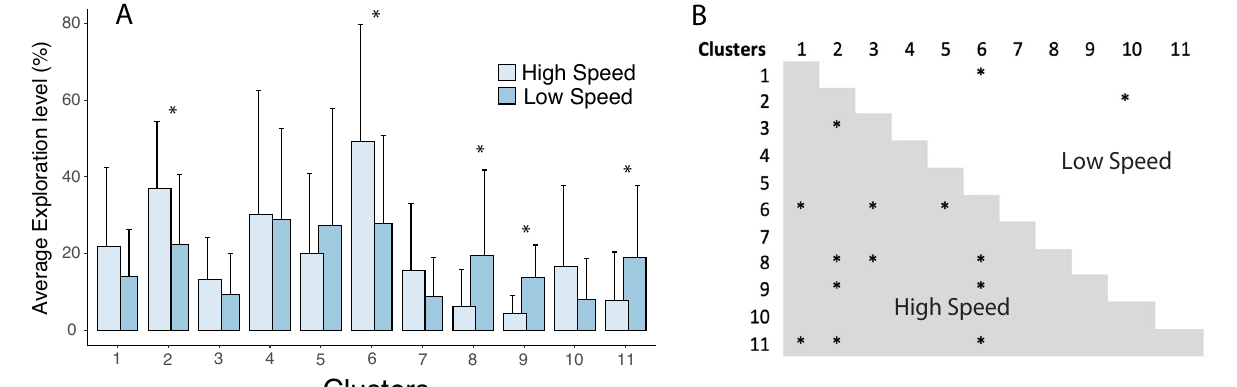
Figure 4. Effect of speed and pattern on exploration. ( A ) Effect of speed condition on the exploration quantity of each specific coordination pattern, the stars showing the patterns that are explored with significant different quantities between both conditions (at p < .05). ( B ) Effect of pattern within each speed condition, the starts showing which pairs of patterns are explored with a significantly different quantity within a specific speed condition (at p <